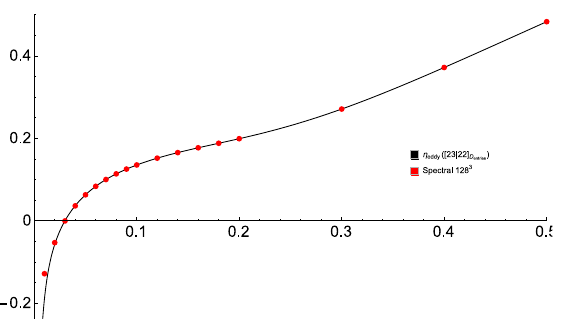
Figure 6. Minimum eddy diffusivity (53) (vertical axis) for the sample flow (49), (51) computed by Padé approximation of the individual entries of the eddy diffusivity tensor D of orders [23/22] for varying magnetic molecular diffusivity η (horizontal axis).